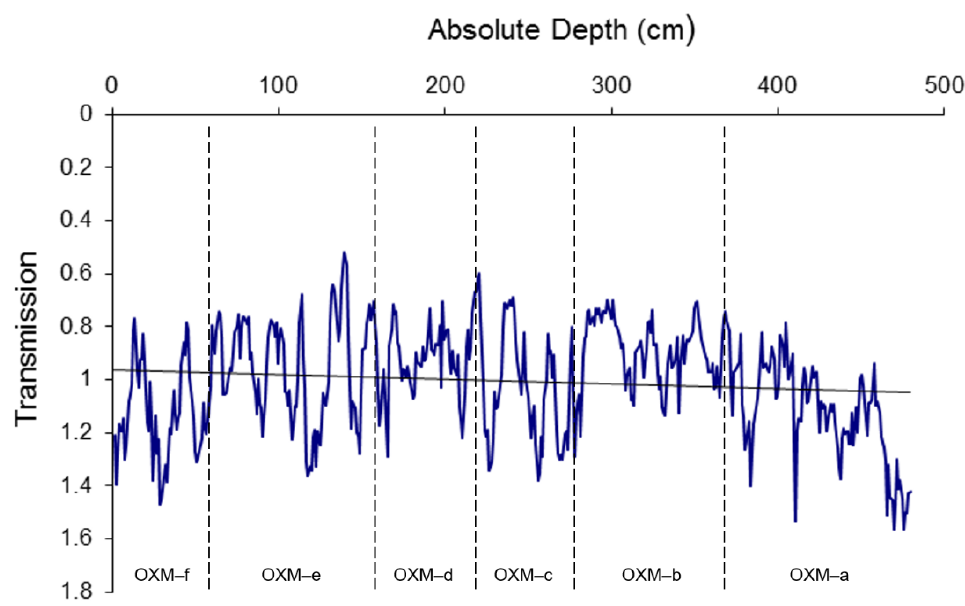
Figure 5. Humification (transmission; raw percentage light transmission results were smoothed exponentially in MS Excel and de-trended using a linear regression model to remove any long-term trends; hence, transmission is no longer expressed as a percentage, but as a number) and depth